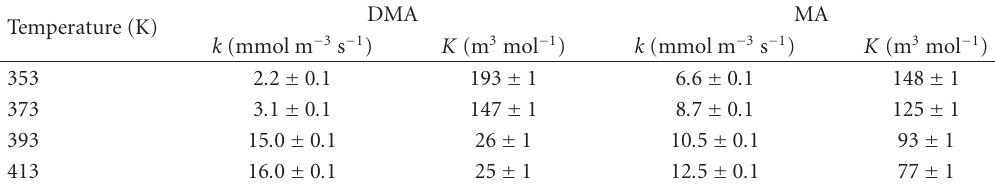
Table 1: Reaction rate constants and Langmuir adsorption coe ffi cients for PCO of DMA and MA on TiO 2 .